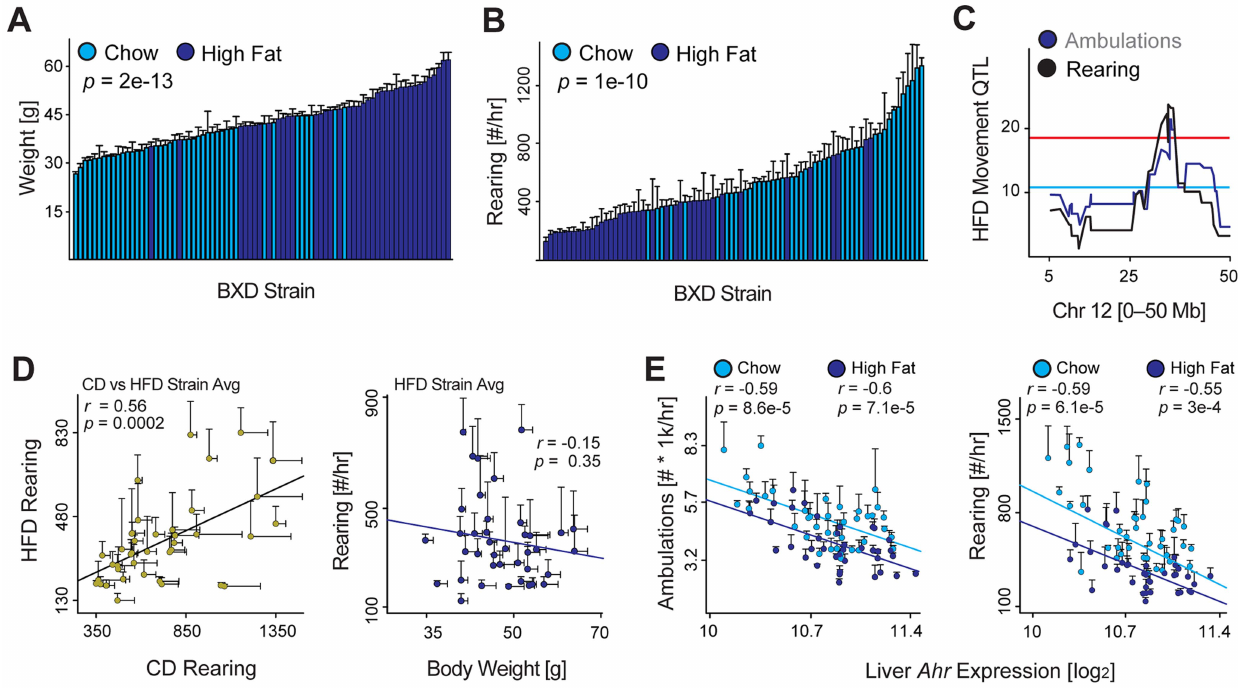
Figure 4. Environmental effects on movement and Ahr . ( A ) Weight is significantly increased in cohorts fed HFD (dark blue) by 23 weeks of age—after 15 weeks on HFD—compared to the CD-fed cohorts (light blue). ( B ) Rearing activity and ambulatory activity are significantly reduced by HFD feeding. ( C ) Both movement parameters also map significantly to the Ahr locus in BXDs fed HFD, indicating that the effect of HFD on movement is independent of this locus. ( D ) Left: Rearing and movement activity in HFD cohorts correlates well with the movement of chow diet (CD) cohorts run previously. Right: Body weight has no effect on spontaneous activity in mice on HFD, which is similar as observed previously for animals on CD. ( E ) Ambulatory activity (left) and rearing activity (right) correlations with Ahr expression in CD and HFD BXD cohorts. Ahr expression is unaffected by HFD.